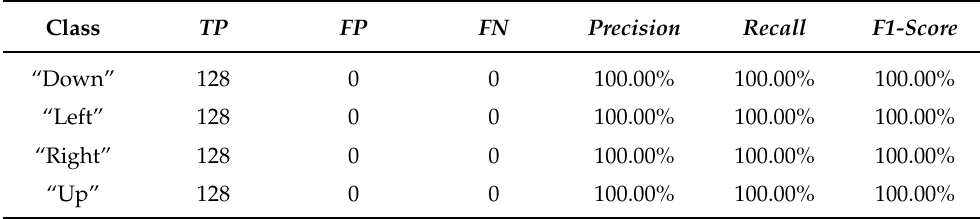
Figure 6. From top to bottom are the split results of the training data being biased towards ( a ) cluster 1; ( b ) cluster 3; ( c ) cluster 4; and ( d ) cluster 5, while the case of cluster 2 is omitted due to its similarity to cluster 1, as discussed in Section 3.3. The dotted lines in the right two plots show the average silhouette values for the corresponding left two plots. The worst case is shown in ( b ), where there is no intersection of clusters and the silhouette distributions are far apart. Table 3. Performance metrics of the network trained and validated with data using our proposed splitting method (Figure 5). There are no wrong